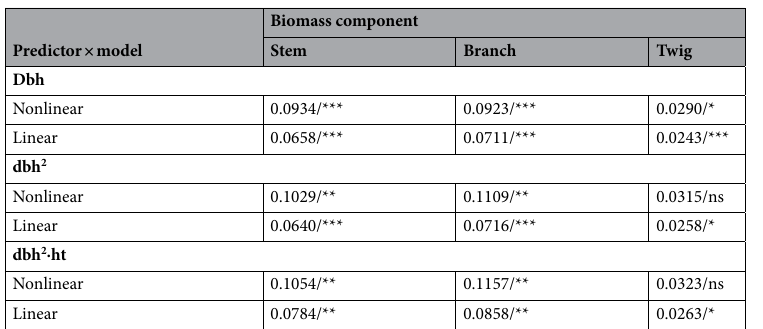
Table 2. Residual standard errors of fitted component ratio method models for the biomass components and for the combination of models and predictors. The biomass components are main stem, large branch, and twig. The two models are nonlinear and linear SUR. The three predictors are dbh, dbh 2 , and dbh 2 ·ht. RSE is residual standard error. The p -values of the estimated parameter β 1 in the fitted Component Ratio Method models (Eqs. 1 and 2) are represented by asterisk next to the reported RSEs: ns ( p > 0.05), * ( p ≤ 0.05), ** ( p ≤ 0.01), *** ( p ≤ 0.001), **** ( p ≤